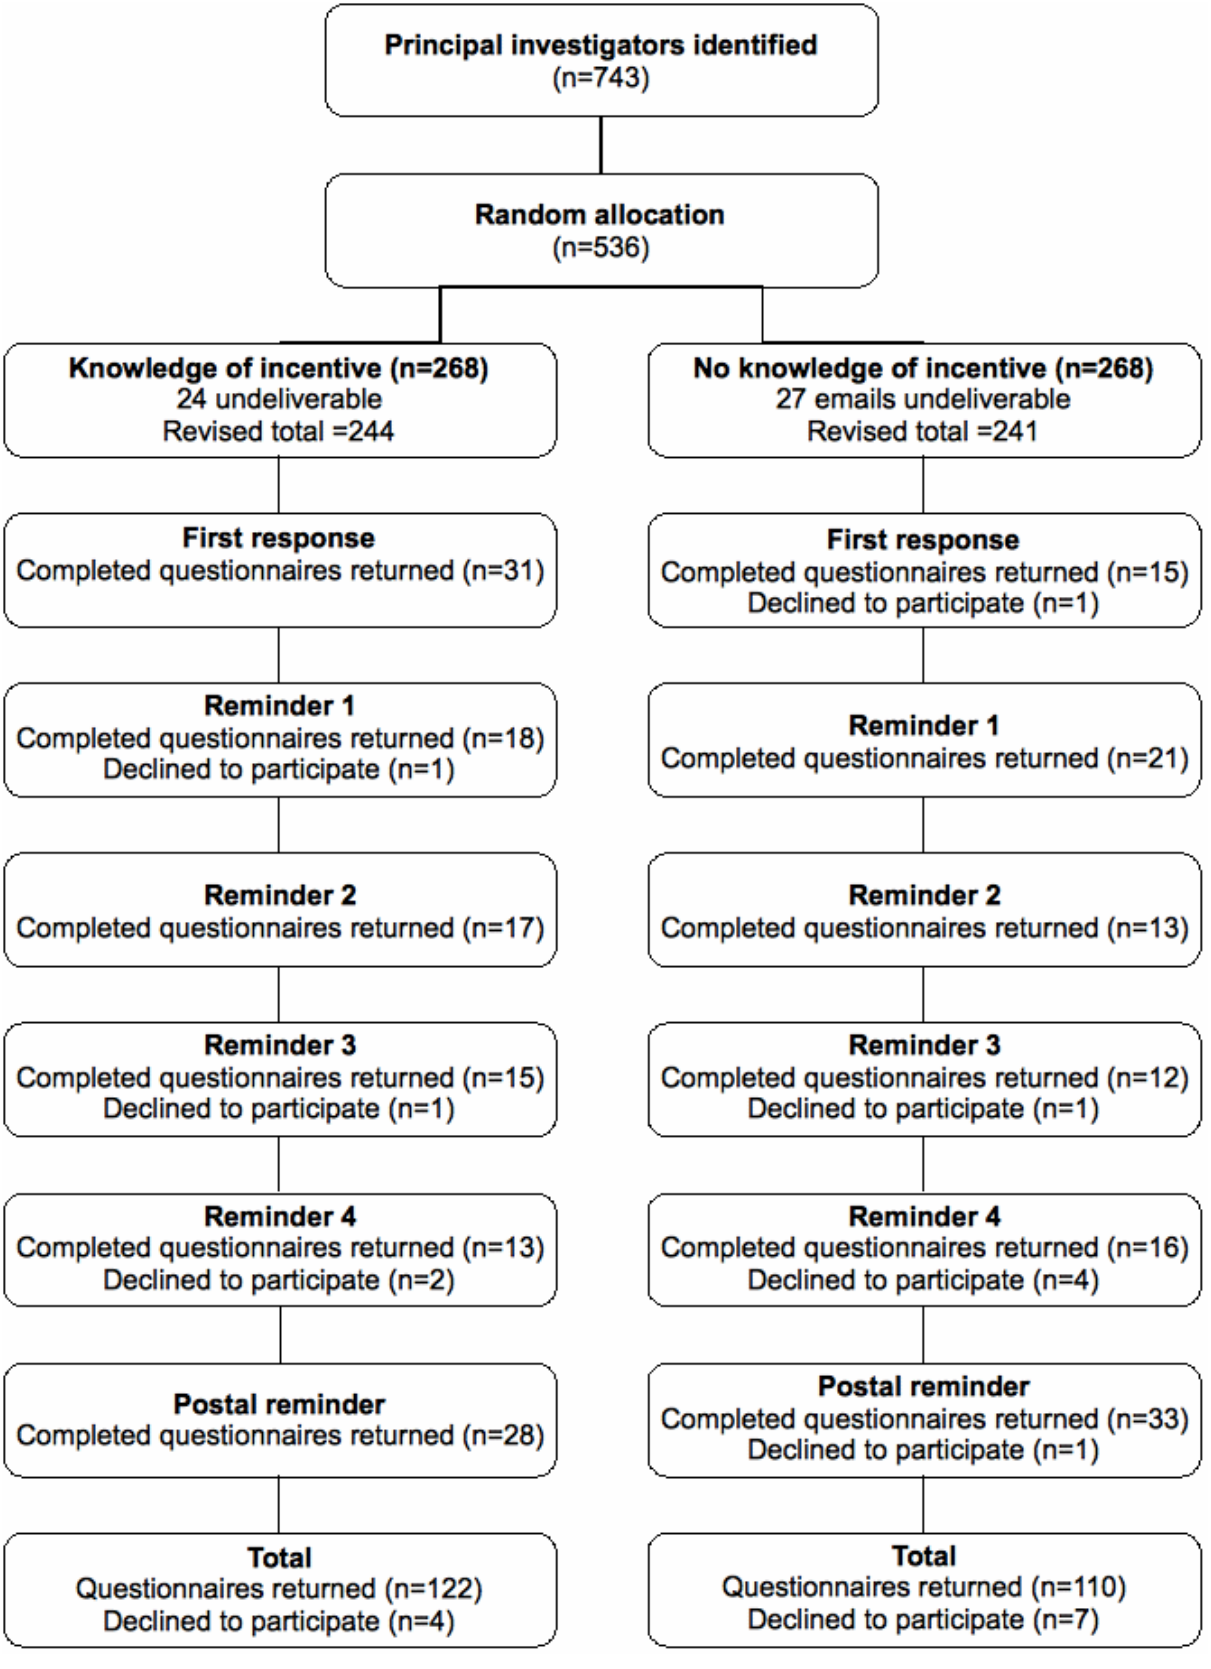
Figure 1. Flow chart of “knowledge of” versus “no knowledge of” financial